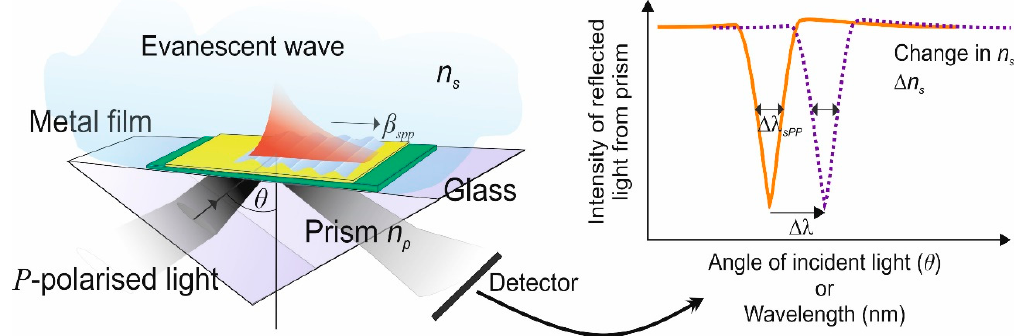
Figure 1. Basic schematic of generation of a surface plasmon resonance.